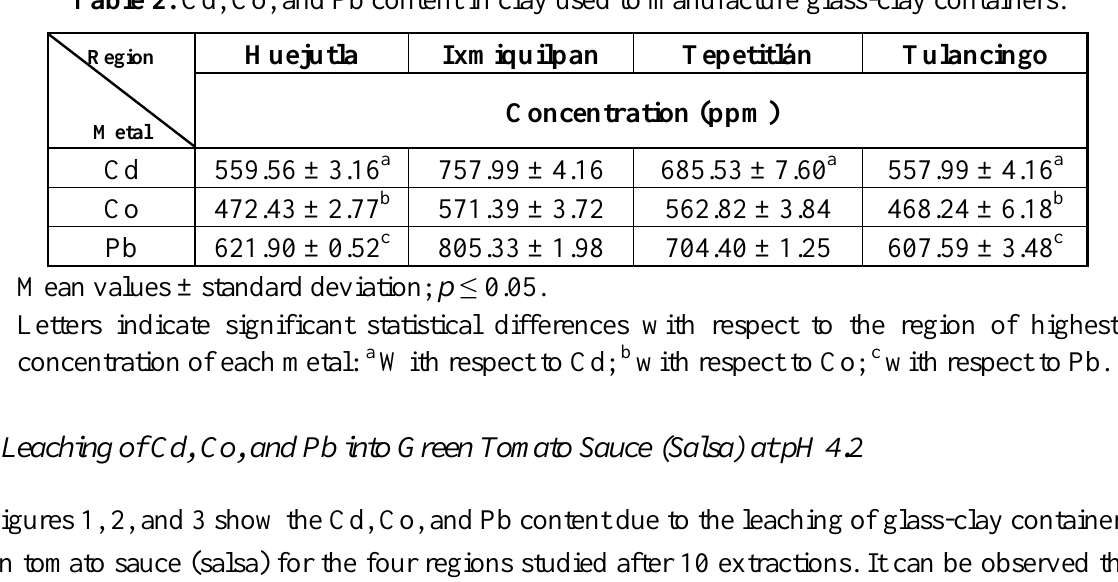
Table 2. Cd, Co, and Pb content in clay used to manufacture glass-clay